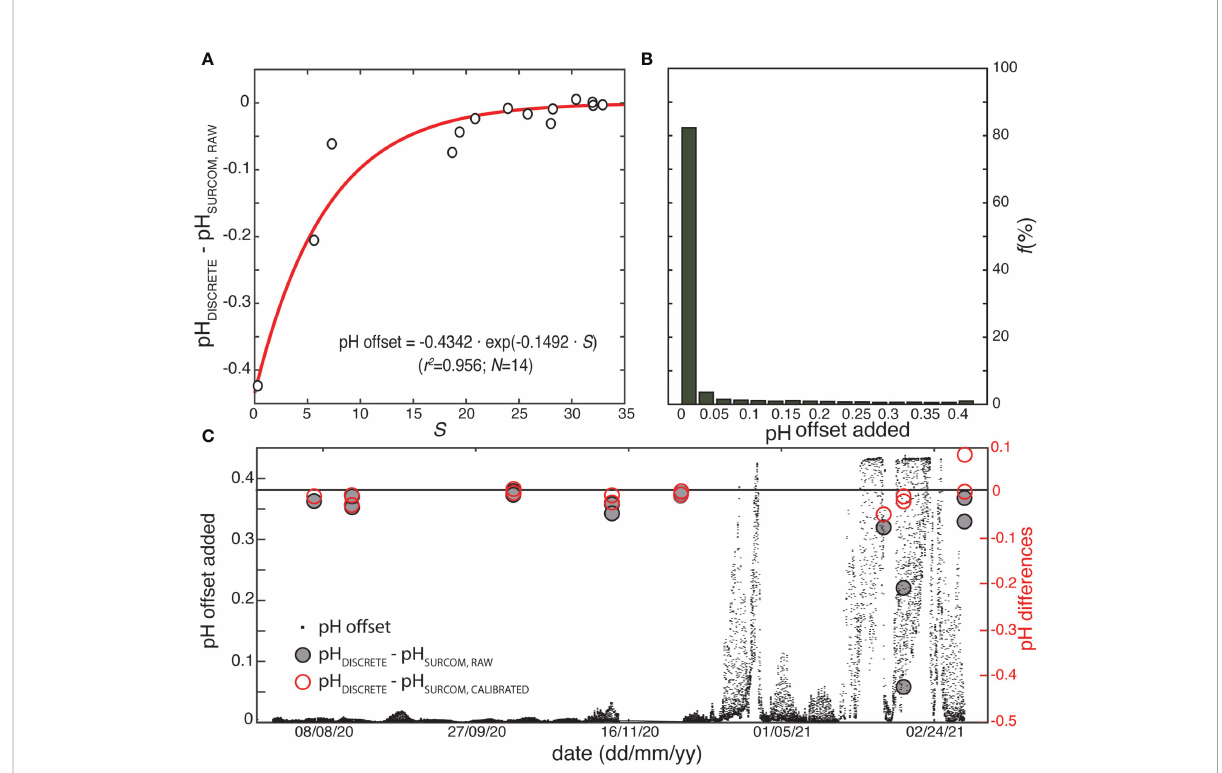
FIGURE 5 (A) Differences in pH between discrete samples and raw SURCOM values (as converted from volts) fi tted to an exponential equation for the estimation of the pH offset as a function of salinity, including determination coef fi cient ( r 2 ) and number of samples ( N ). (B) Percentage of pH adjustments values added as offset for calibrating raw SURCOM pH. (C) pH calibration offset added to SURCOM raw values (black dots) throughout the study period including the differences between discrete samples and raw SURCOM pH values (dark circles) and the differences between discrete samples and calibrated SURCOM pH values (red